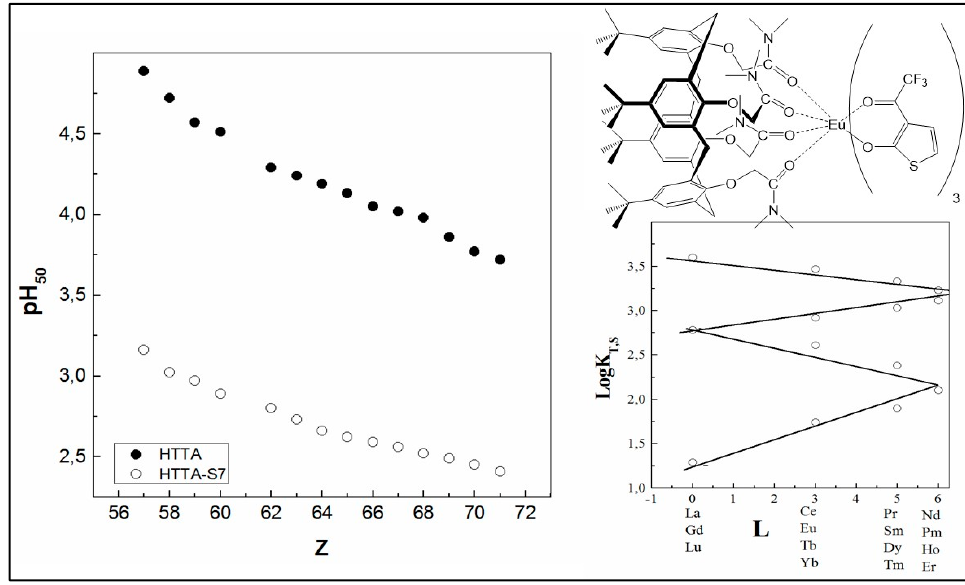
Figure 8. Comparison of the pH 50 values for the extraction of Ln (III) ions with HTTA in the absence and in the presence of tert -butylcalix[4]arene tetrakis(N,N-dimethylacetamide) (S) in CCl 4 . Proposed structure of the isolated solid complex Eu (TTA) 3 · S. Adaptation from Ref. [61] with permission.